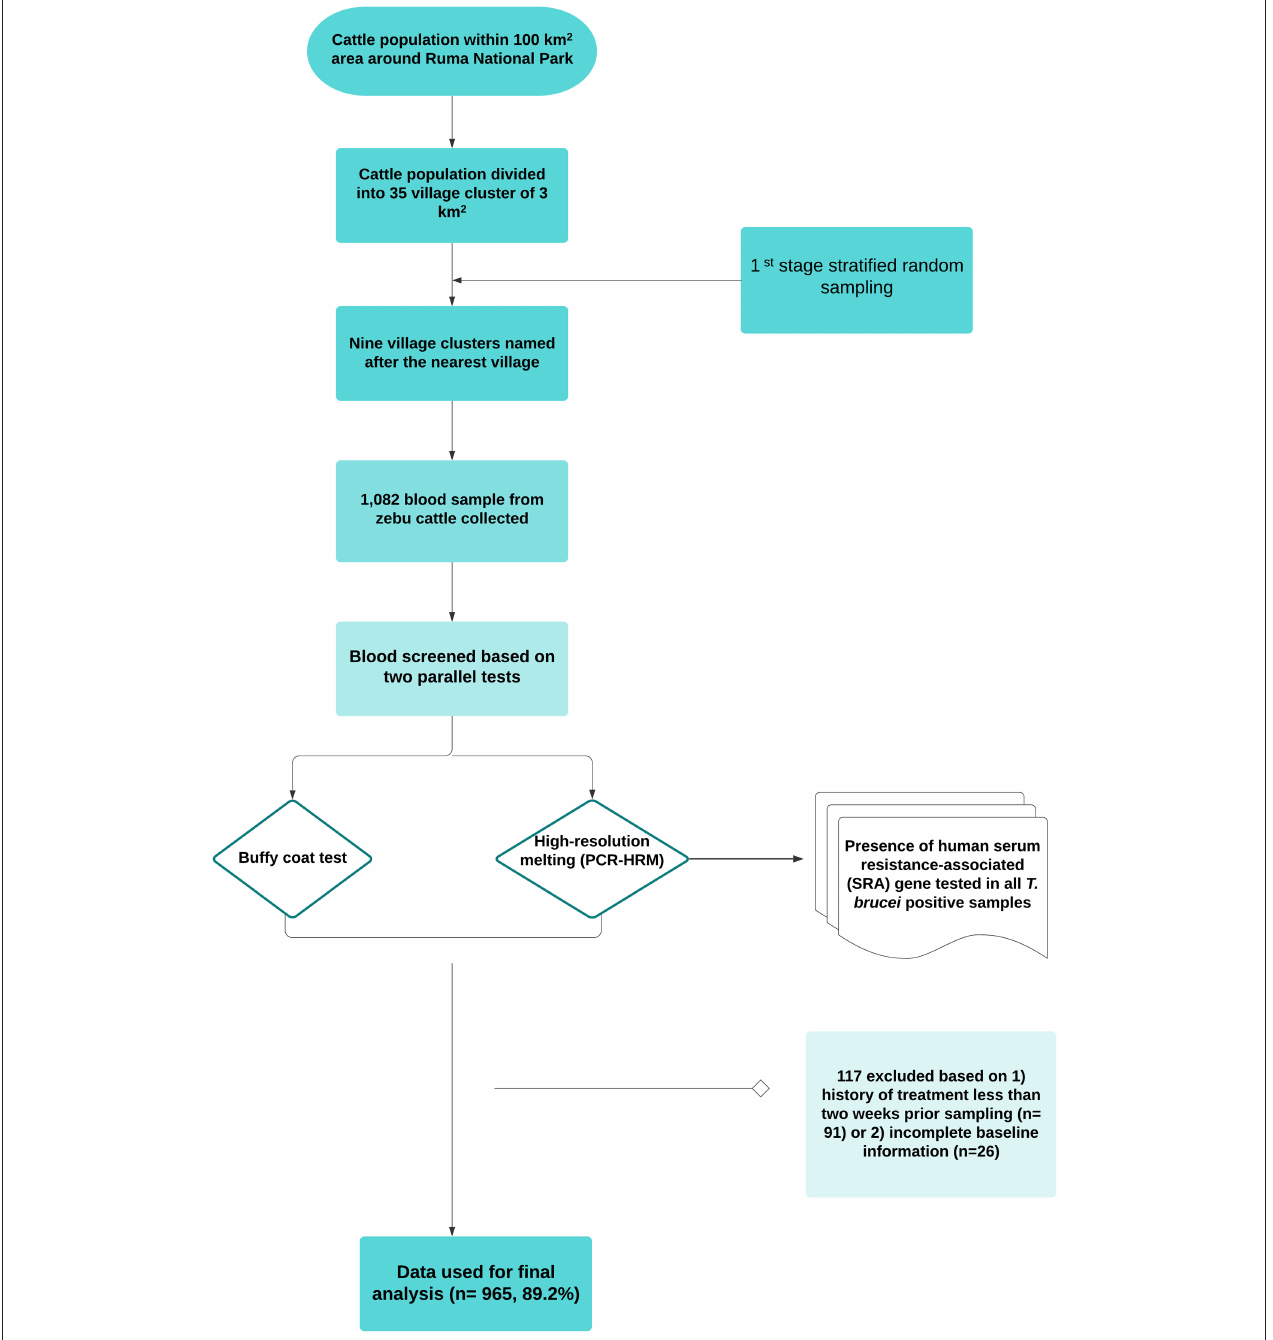
FIGURE 2 | Workflow of the study design and sampling.